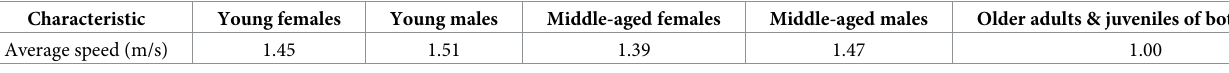
Table 2. Walking speed stratified by age and gender.